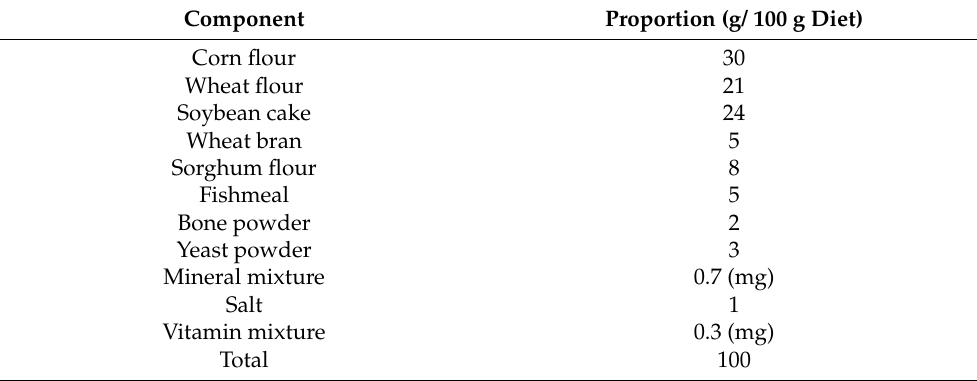
Table 1. Structure of the mice